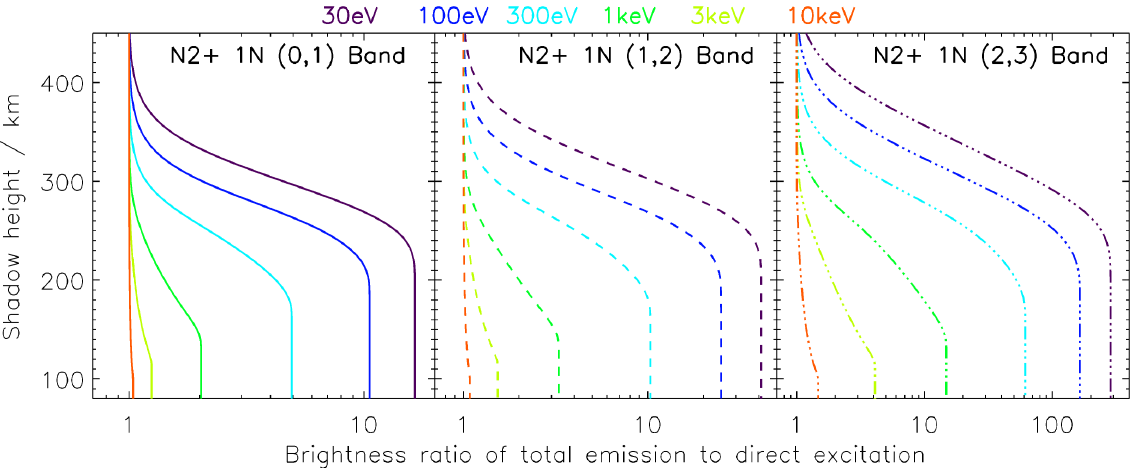
Fig. 9. The brightness of N + 1N (0,1), (1,2) and (2,3) bands with respect to the brightness of the same bands from direct excitation for a 2 range of input electron energies.